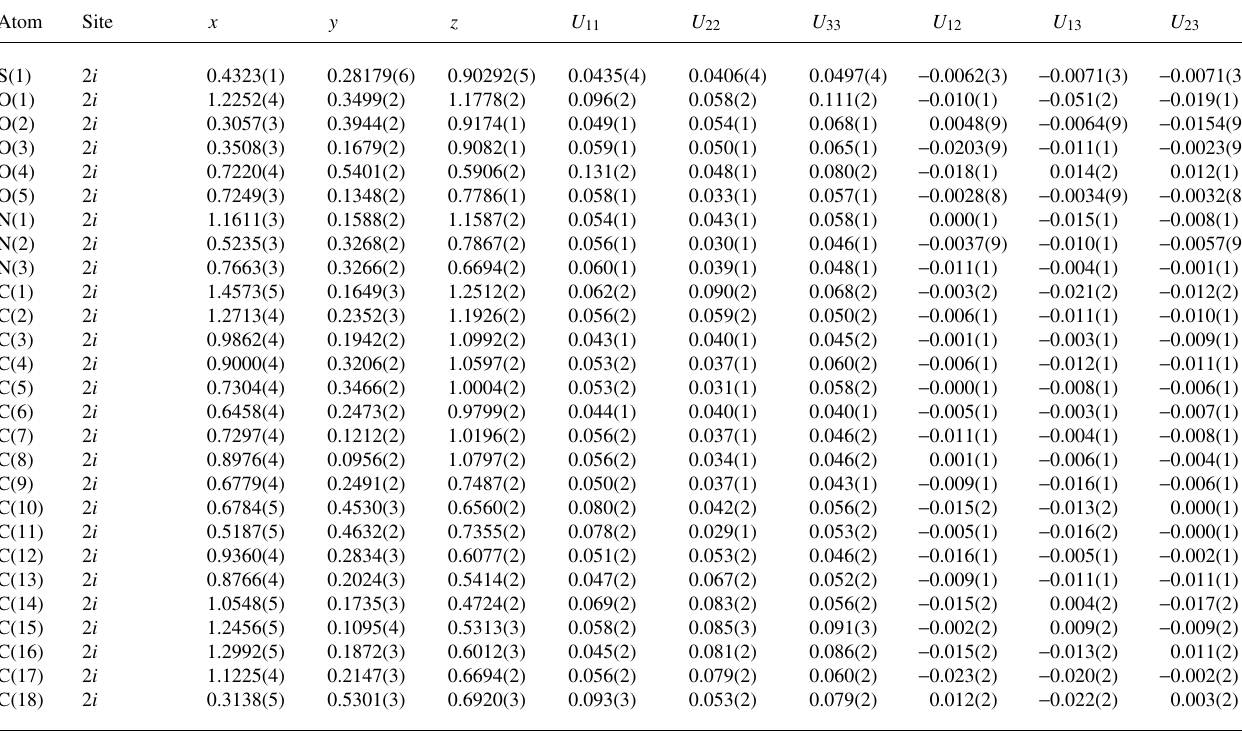
Table 3. Atomic coordinates and displacement parameters (in Å 2 ) .